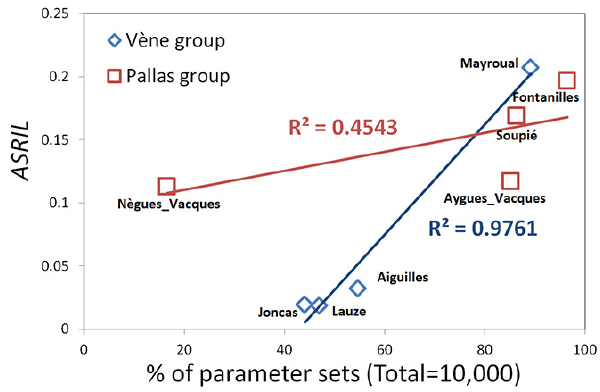
Figure 7. Relationship between the number of transferred model parameter sets and the ASRIL factor at the ungauged